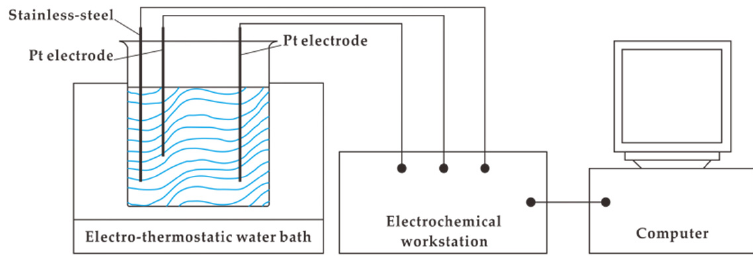
Figure 1. Schematic diagram of the stainless steel coloring device.